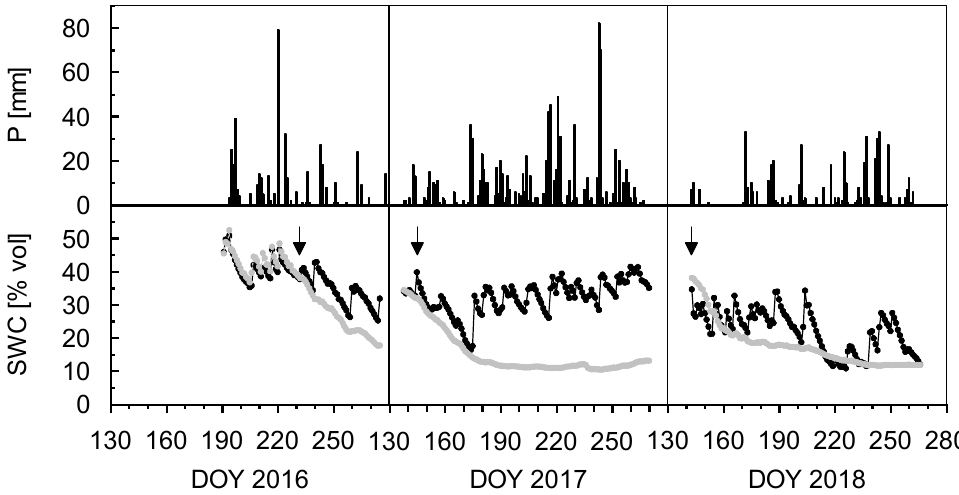
Figure 1. Seasonal course of daily sum of precipitation (P) and daily mean soil water content (SWC) at 5–10 cm soil depth in control (black) and rain exclusion plots (grey) from 10 July–2 October 2016, 18 May–27 September 2017, and 23 May–23 September 2018. SWC data are the mean of three sensors per treatment. Arrows indicate the start of rain exclusion.